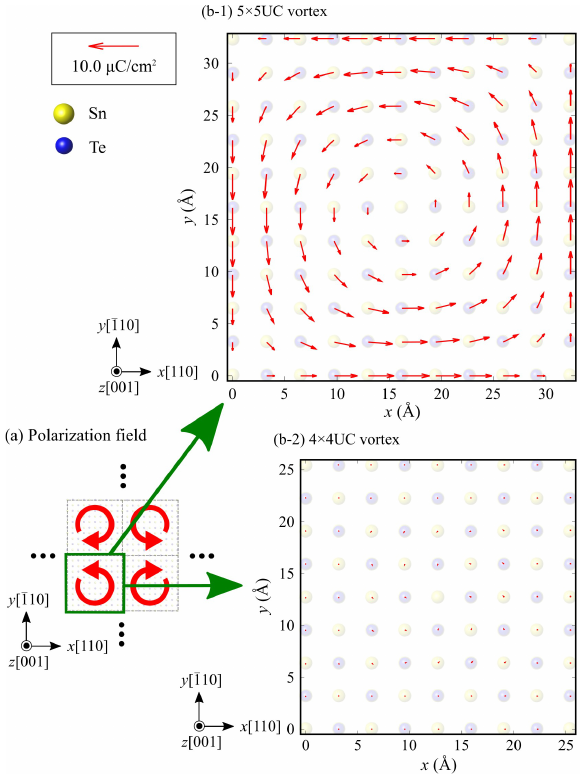
Figure 10. Vector-field representation of the spontaneous polarization of the imaginary edge-free SnTe models with a polarization-vortex periodicity of ( a ) 5 × 5 and ( b ) 4 × 4 unit cells. Red arrows indicate spontaneous polarization.